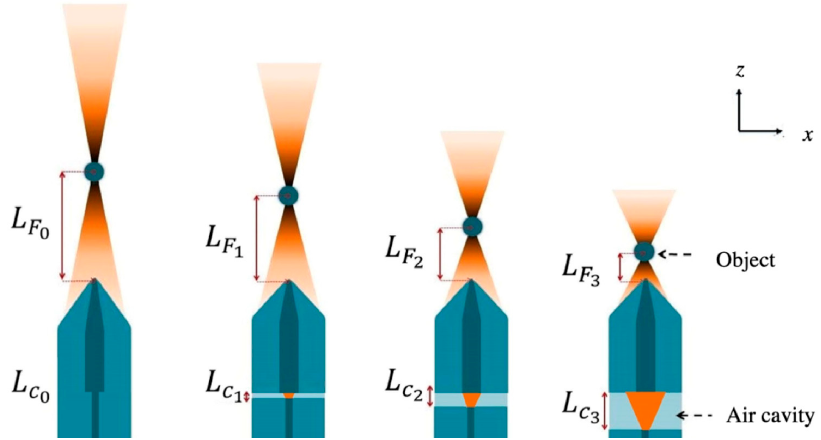
Figure 7. Principle of controllable optical manipulation based on air cavity length.